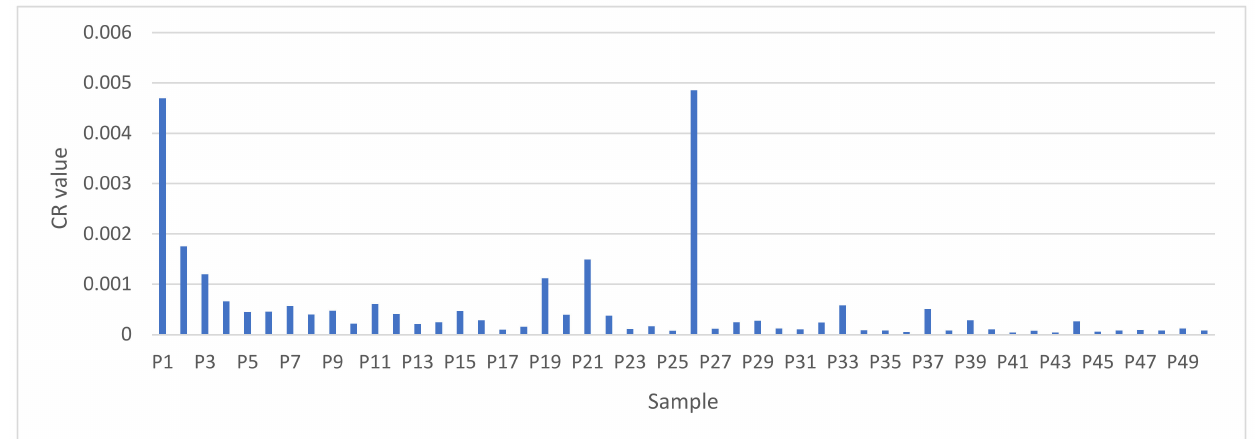
Figure 2. Total cancer risk values of the tested